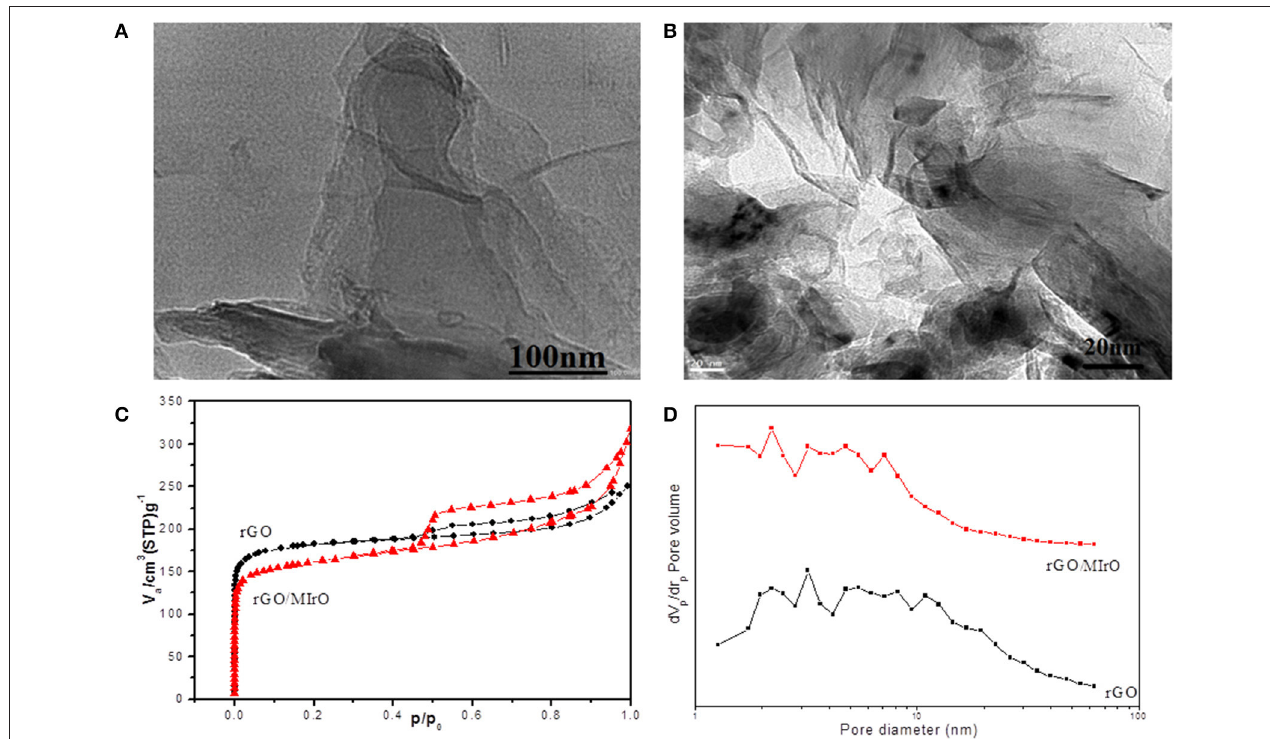
FIGURE 2 | TEM images for (A) rGO and (B) rGO/MIO samples. (C) N 2 -adsorption-desorption isotherm and (D) BJH plot of rGO and rGO/MIO nanocomposite.